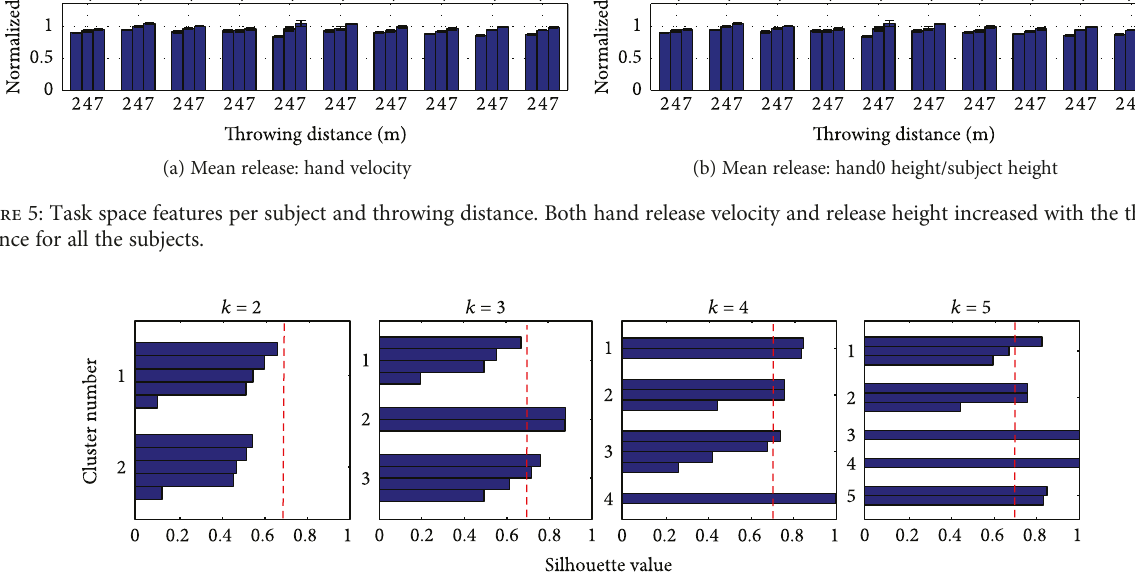
Figure 6: Task space cluster separation quality using k -means. Strongly separated clusters Sil ≥ 0 71 containing a similar number of subjects cannot be found. A single cluster exists across subjects.